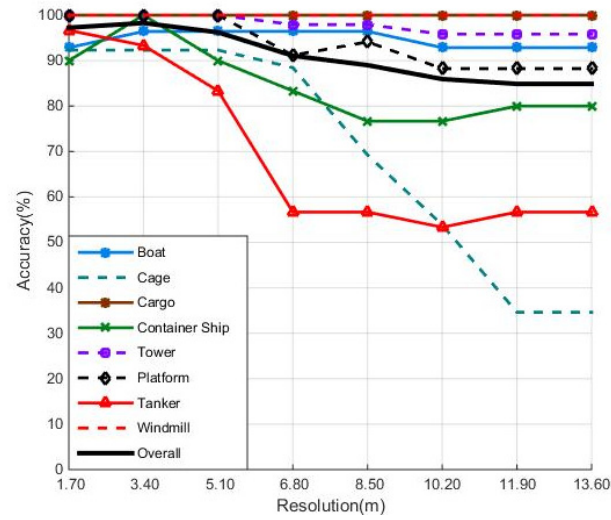
Figure 9. Classification accuracies of MT-CNN under different ground resolutions.